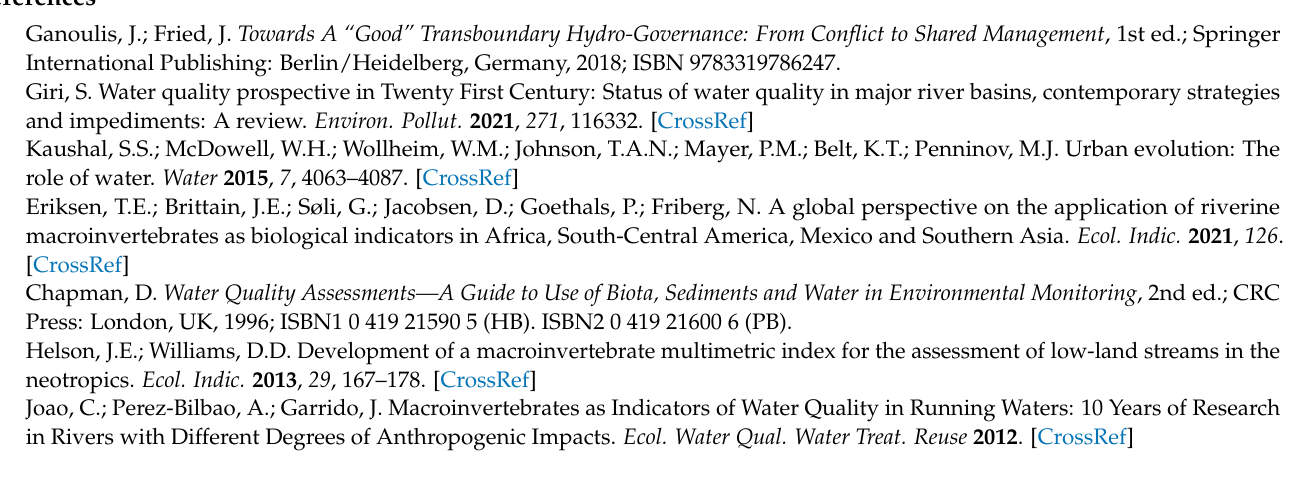
Figure A1. Photographs of the sampling sites on the Coca and Aguarico Rivers. The letters distinguish the place where the images were taken, being ( a ) the Rev2 site, ( b ) the Loc1 and Sal1 sites, ( c ) the Cha1, ( d ) the Lum3 and Lum4 sites, ( e ) the Dui1 site, and ( f ) the Ph1 and Ph2 sites.